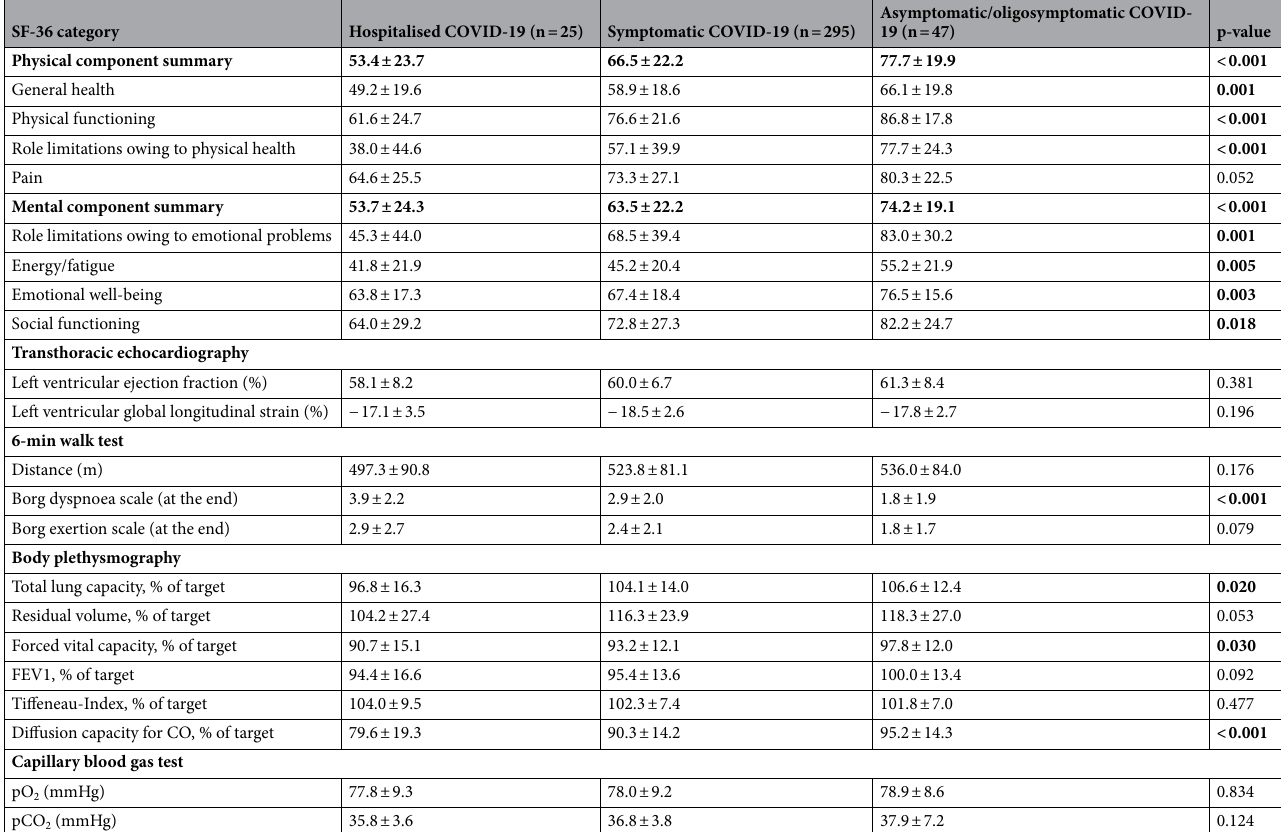
Table 2. Results of SF-36 evaluation and results of transthoracic echocardiography, 6-min walk test, body plethysmography and capillary blood gas test in dependency of initial disease severity. Variables are expressed as means ± standard deviations. Significant values are in